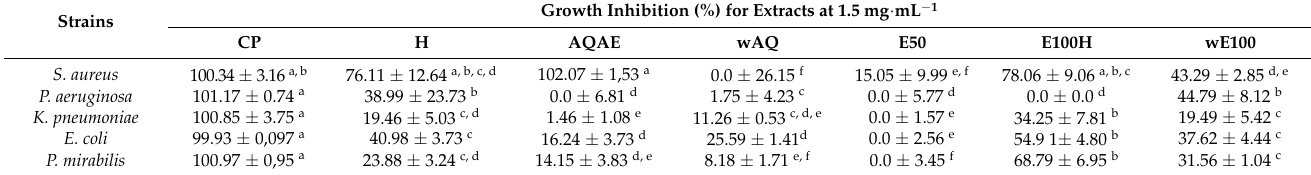
Table 2. Antimicrobial activity of all the six extracts of Undaria pinnatifida at 1.5 mg · mL − 1 by broth microdilution assay against Staphylococcus aureus , Pseudomonas aeruginosa , Klebsiella pneumoniae , Escherichia coli , and Proteus mirabilis . Inhibition control was obtained using ciprofloxacin (CP). The results represent the mean ± SD of triplicate experiments. For each of the species, the differences between extracts were evaluated using Tukey’s test. Values with the same superscript letters do not have statistically significant differences ( p > 0.05).